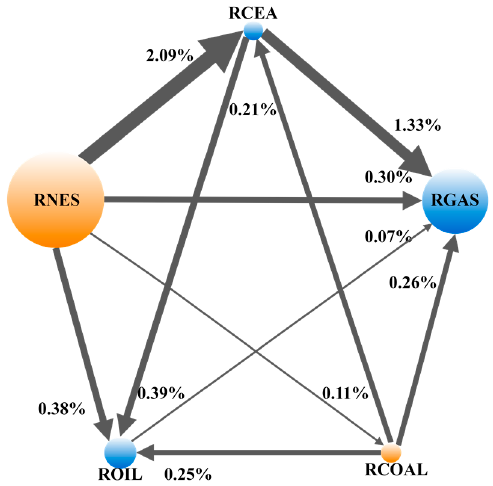
Figure 2. The net pairwise connectedness of the carbon trading market, new energy stock market, and fossil energy market in the original return system. The color of the node in the figure represents whether it is a net transmitter or a net receiver. Net transmitters are shown in orange and net receivers are shown in blue. The size of the node shows the value of the net spillover; the larger the node, the larger the value of the net spillover. The thickness of the arrow line indicates the degree of information spillover; the thicker the line, the higher the degree of spillover between markets.